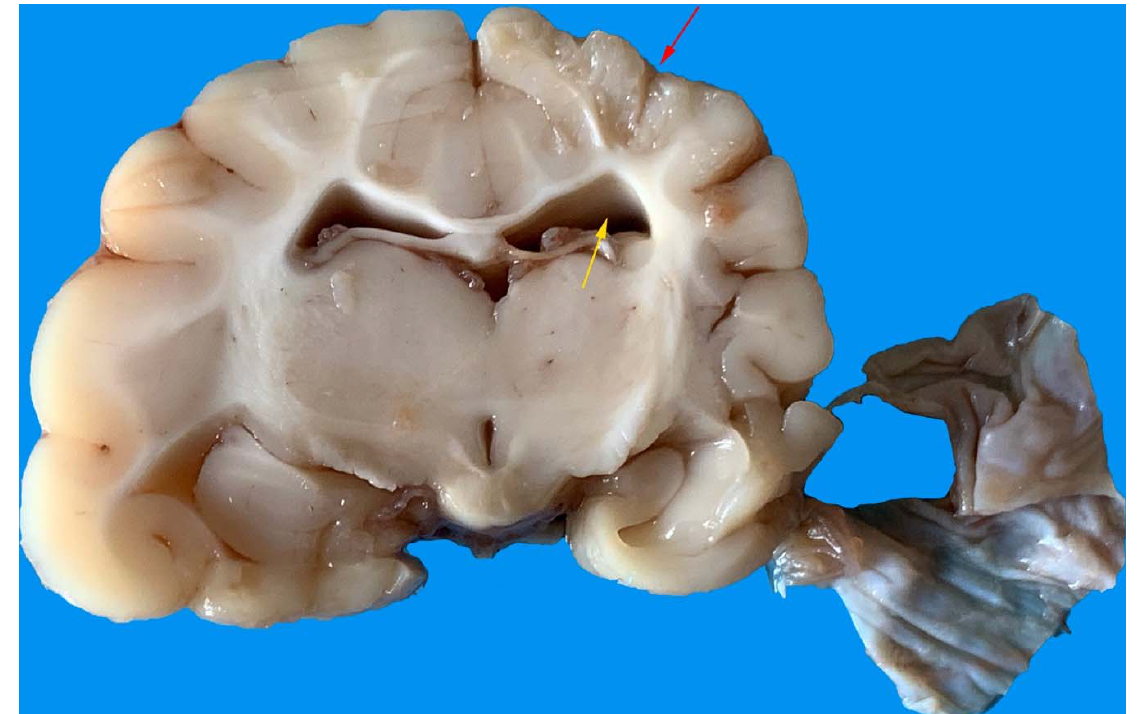
Figure 5. Temporoparietal portion of the left lobe of the brain with less compact areas (red arrow). The ventricles and furrows were enlarged (yellow arrow).